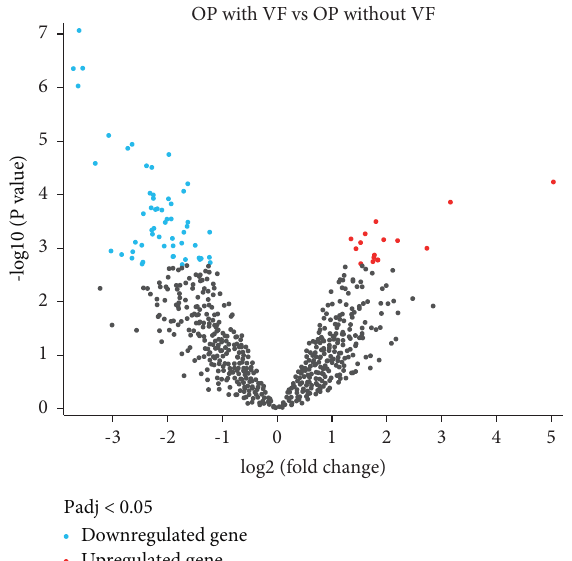
Figure 1: The volcano plot presenting differentially expressed miRNAs (|log2 (fold change)| ≥ 2, adjusted P < 0.05) between osteoporotic patients with vertebral fractures and osteoporotic patients without fracture. Table 1: Differentially expressed miRNAs that were upregulated or downregulated |log2 (fold change)| ≥ 2 (corrected P < 0.05) between osteoporotic patients with vertebral fractures and osteoporotic patients without fracture. miRNA_ID Log2 (fold change) Adj. p value